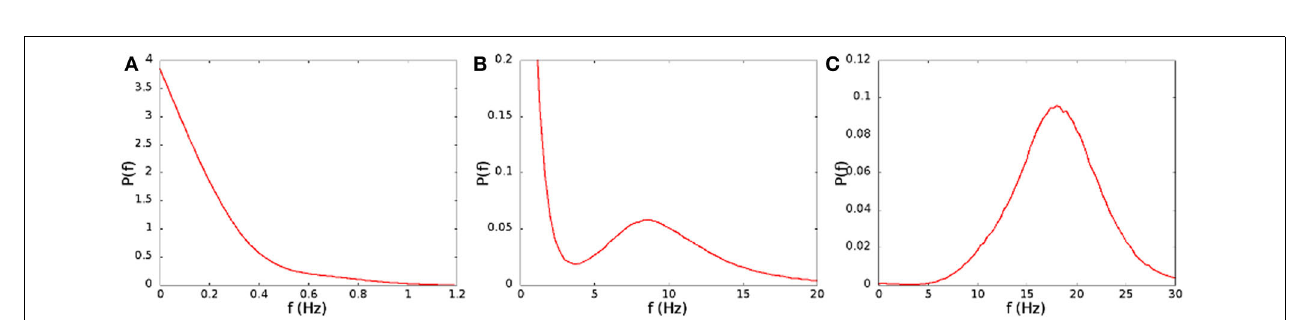
FIGURE 2 | (A) The average spiking rate in Hz per neuron, as a function of the noise level α and the connection strengths H 0 . (B) Shape of the firing rate distribution: nearly exponential (yellow), nearly Gaussian (red), or bimodal (green). The letters on the plot mark the points whose rate distribution is shown in Figure 3 , and whose activity is shown as a raster plot in Figure 4 .